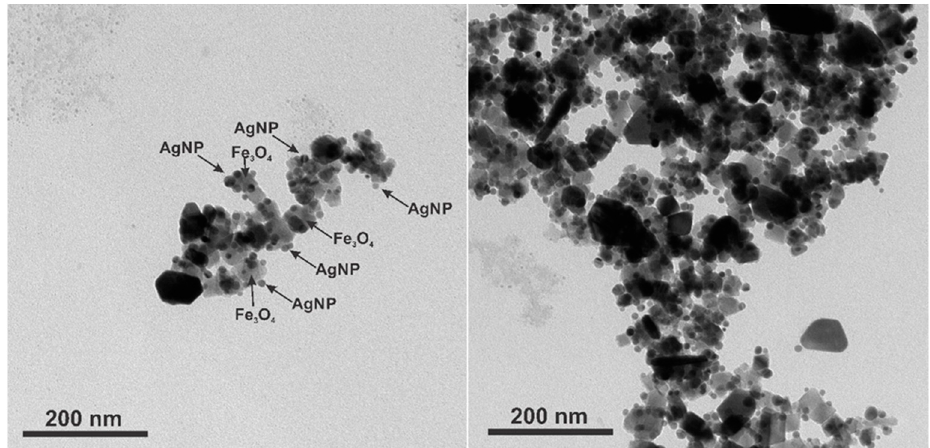
Figure 8. TEM images of cubic magnetite covered with spherical silver nanoparticles (Fe 3 O 4 @AgNP_0.5).